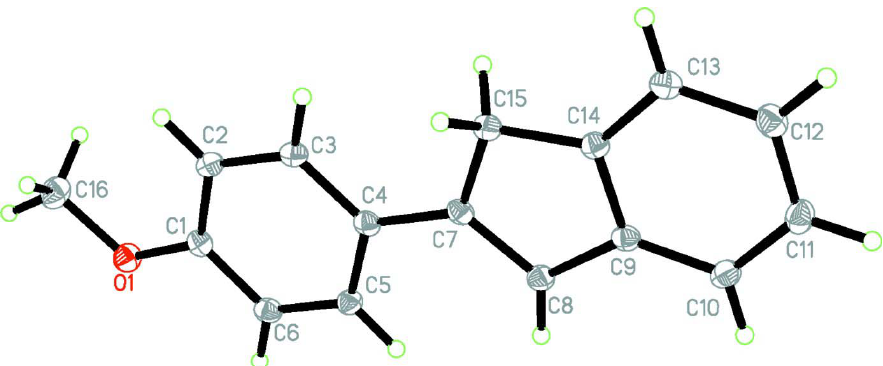
Figure 1 View of the molecule of (I) showing the atom-labelling scheme. Displacement ellipsoids are drawn at the 35% probability